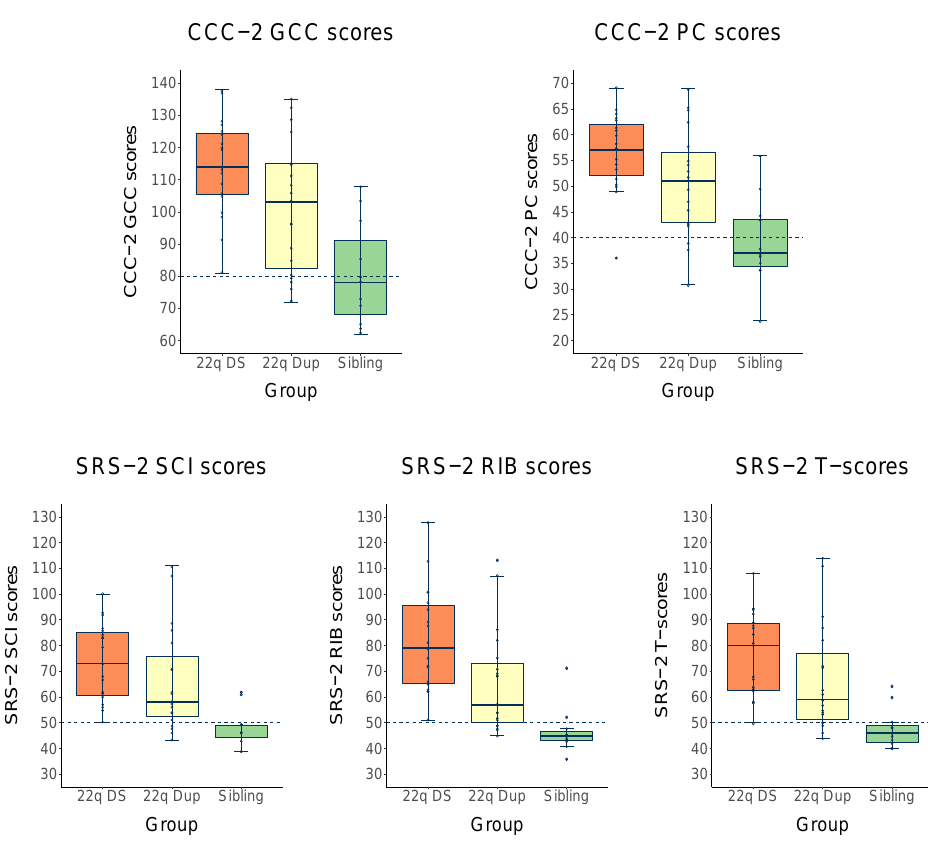
Figure 1. Boxplots for CCC-2 and SRS-2 composite scores across groups. The dashed lines show norm group averages. The gray zones indicate the severity of the problems; the darker the gray, the more severe the difficulties: mild–moderate = light gray zone and severe = darker gray zone, based on clinical cut-off scores for CCC-2 and SRS-2. Abbreviations. GCC, General Communication Composite (norm group average = 80, cut-off: >104 = mild–moderate (pc 10), ≥ 117 = severe (pc 2)); PC, Pragmatic Composite (norm group average = 50, cut-off: >53 = mild–moderate (pc 10), ≥ 60 = severe (pc 2)); SCI, Social Communication and Interaction, RIB, Repetitive interests and behavior, Total (norm group average = 50, cut-off: >60 = mild – moderate (pc 16), ≥ 76 severe (pc 1.8)).